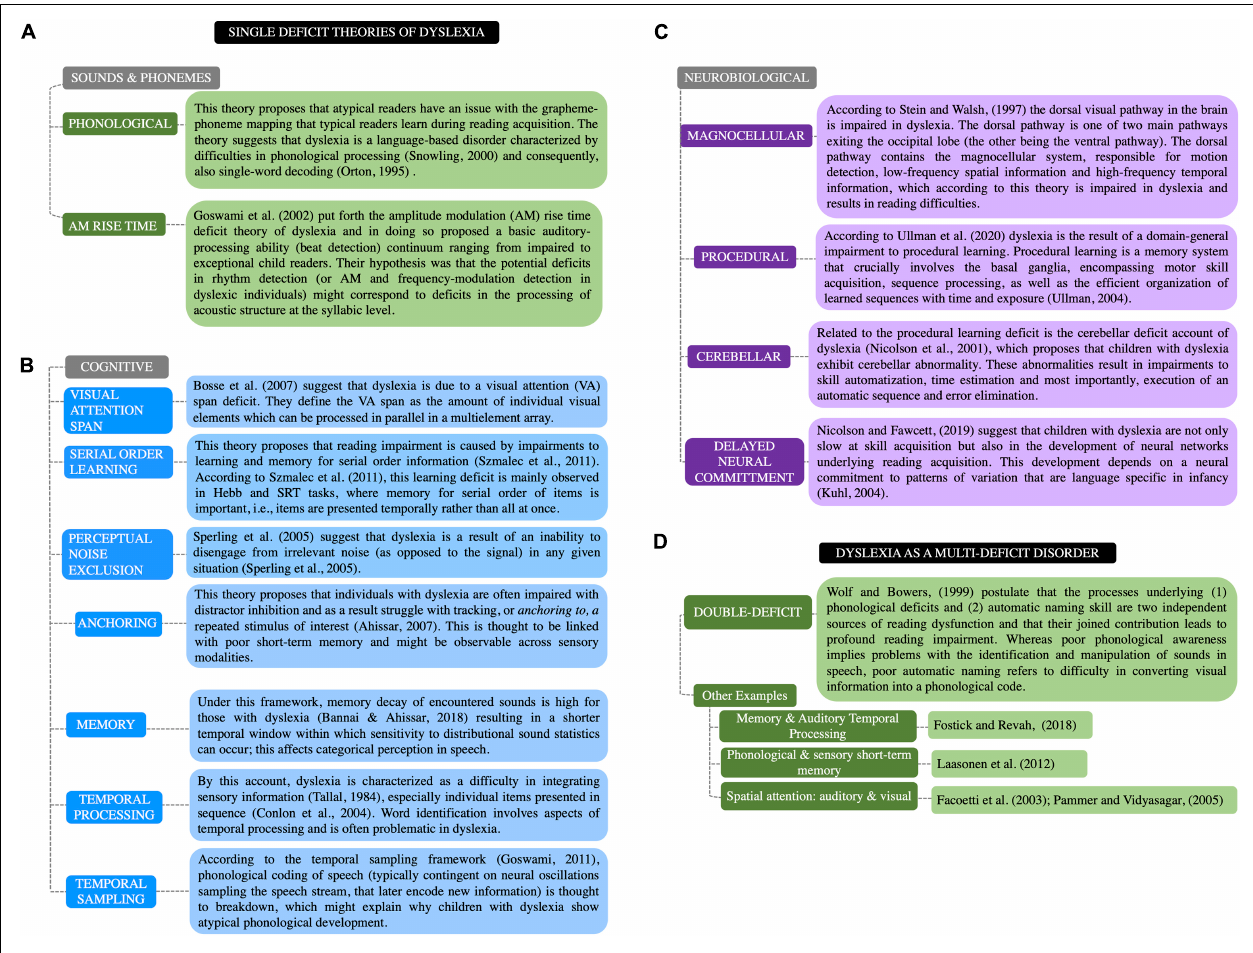
FIGURE 1 | Theoretical framework for dyslexia. (A–C) Single deficit theories of dyslexia. (D) Multiple deficit theories of dyslexia. The single deficit theories are clustered by category [ (A) sounds and phonemes; (B) cognitive; (C) neurobiological]. Each theory is appropriately labeled (left); each is accompanied by a brief description